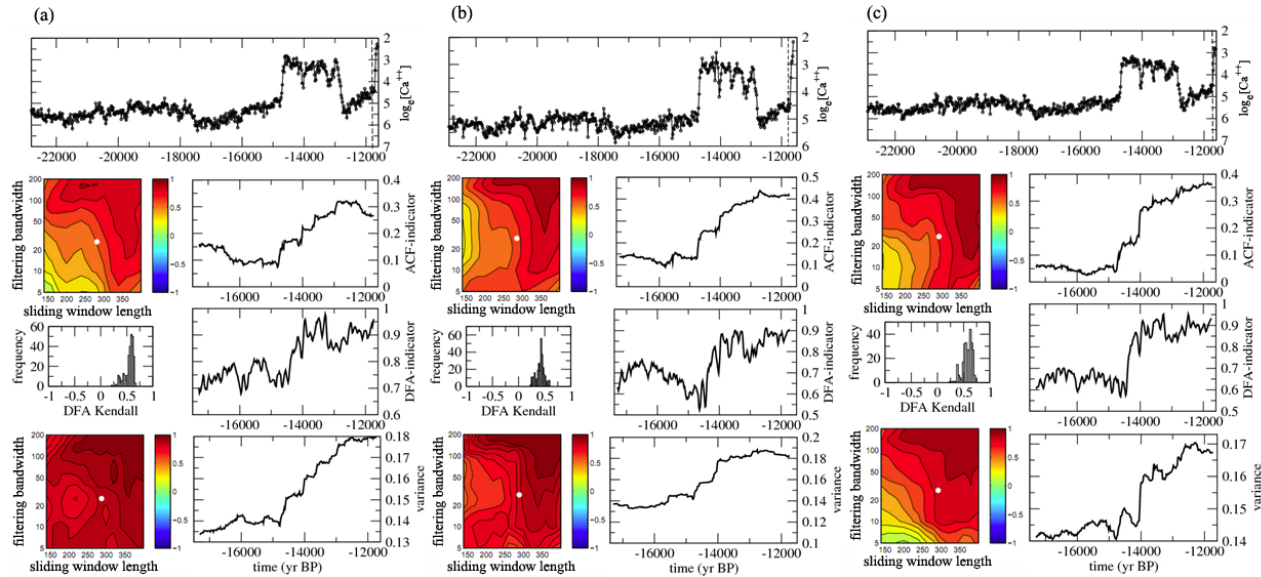
Fig. 4. Indicators of slowing down and changing variance in Greenland ice-core log e [Ca ++ ] records through the last deglaciation: (a) GRIP (b) GISP2 (c) NGRIP. Panel descriptions are as in Fig.